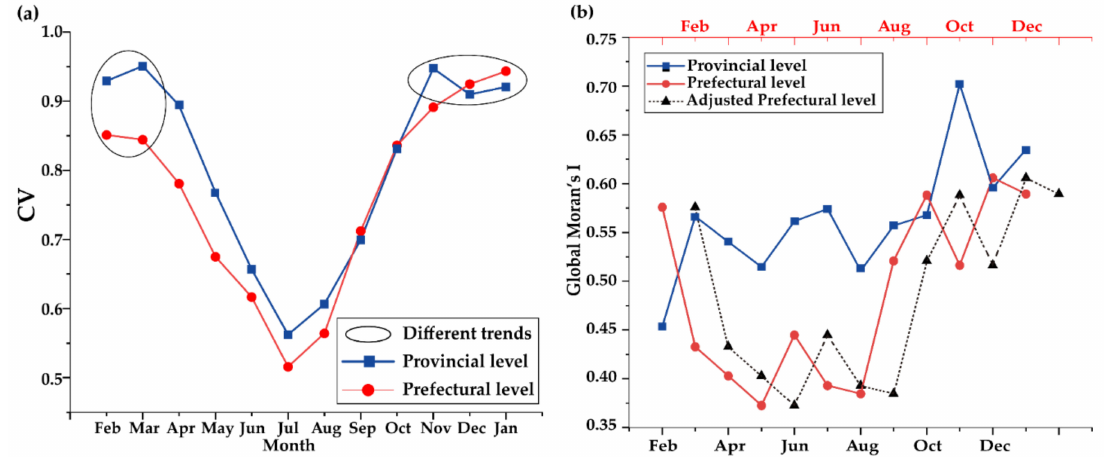
Figure 10. The comparison of CV and Global Moran’s I of provincial and prefectural